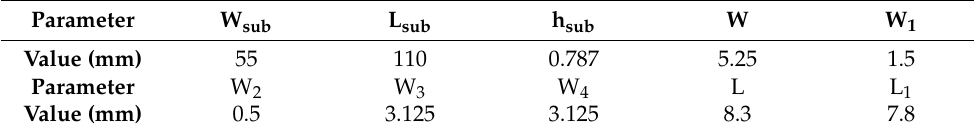
Figure 2. Details of the introduced array’s configuration and design. Table 1. Final dimensions of the 5G antenna parameters.